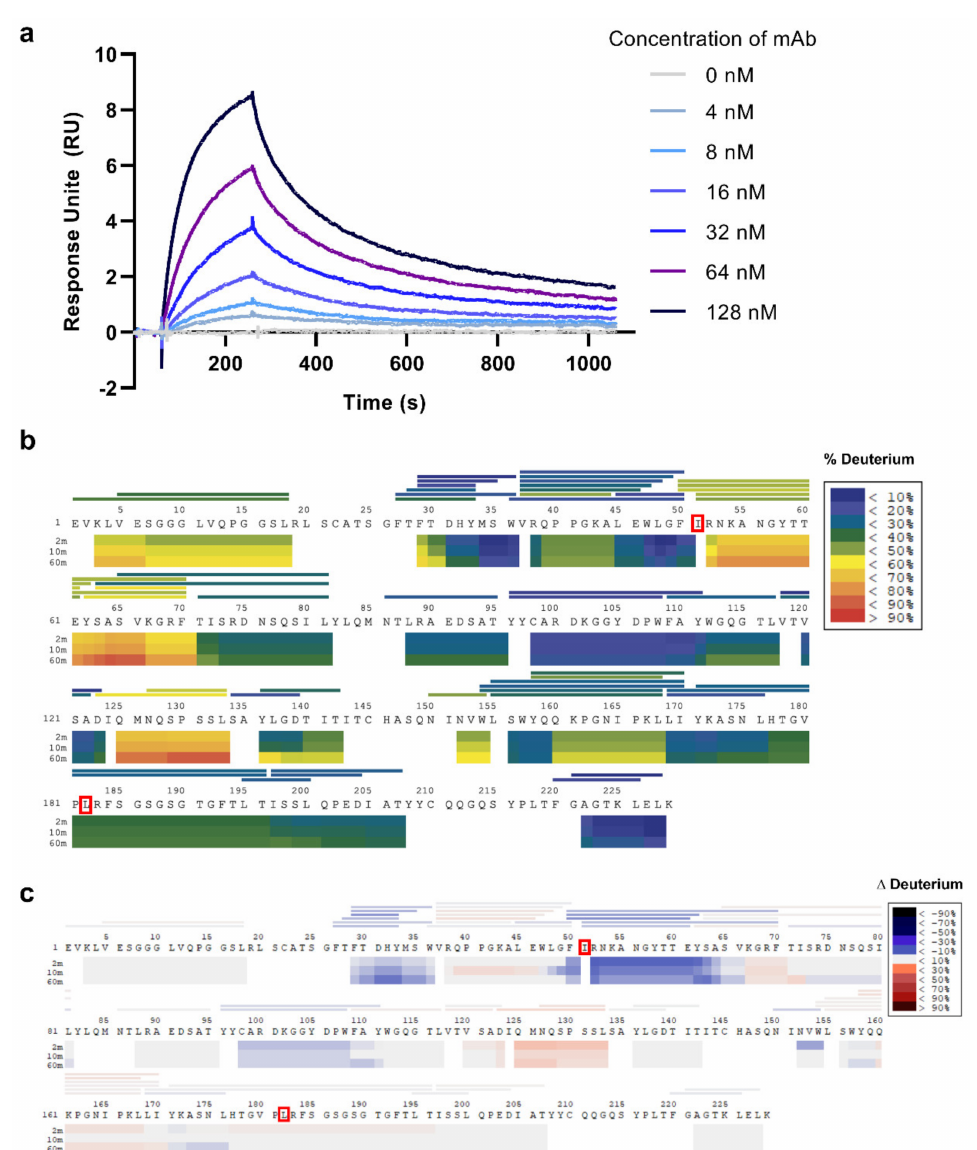
Figure 3. Characterization of binding interface between 1A3 mAb and aHSA. ( a ) The sensorgram of mAb/aHSA interaction at different mAb concentrations. ( b ) The coverage of the 1A3 sequence by reporter peptic fragments (horizontal lines) in HDX MS analysis and the background deuterium incorporation (horizontal bars). ( c ) The differential deuterium incorporation between the mAb/aHSA complex and the mAb alone. Negative values (in blue) represent protection/stabilization while positive values (in red) indicate